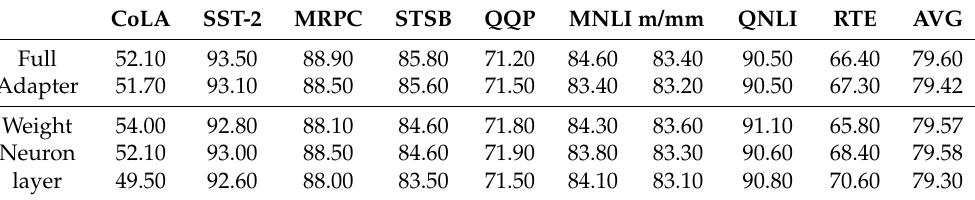
Table 1. Test results on GLUE test sets using the GLUE server. CoLA is evaluated using Matthew’s correlation. STS-B is evaluated using Spearman’s correlation coefficient. MRPC and QQP are evaluated using F1 score. The rest of the tasks are evaluated by accuracy. For three pruning schemes, the best model on the validation set is